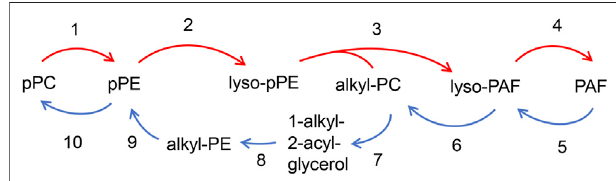
FIGURE 3 | Interconversion pathway between plasmalogen and PAF. pPC can interconvert with pPE via head group transfer (reaction 1 and 10), Plasmalogen PE (pPE) is hydrolyzed by PLA 2 to form lyso-pPE (reaction 2). The lyso-PE can be further reacylated by CoA-IT to form lyso-PAF (reaction 3) with the presence of alkyl-PC, and is subsequently converted to PAF by lyso-PAF AcT (reaction 4). PAF can be converted to pPE through the several steps. Losing its acetyl group by PAF-AH (reaction 5) forms lyso-PAF, which can be further converted to alkyl-PC by LPCAT (reaction 6). The alkyl- PC might be hydrolyzed by PLC to form 1-alkyl-2-acyl-glycerol (reaction 7), whichthenisconvertedtoalkyl-PEbyE-PT(reaction8),andalkyl-PEisfurther converted to pPE with Δ 1 desaturase (reaction